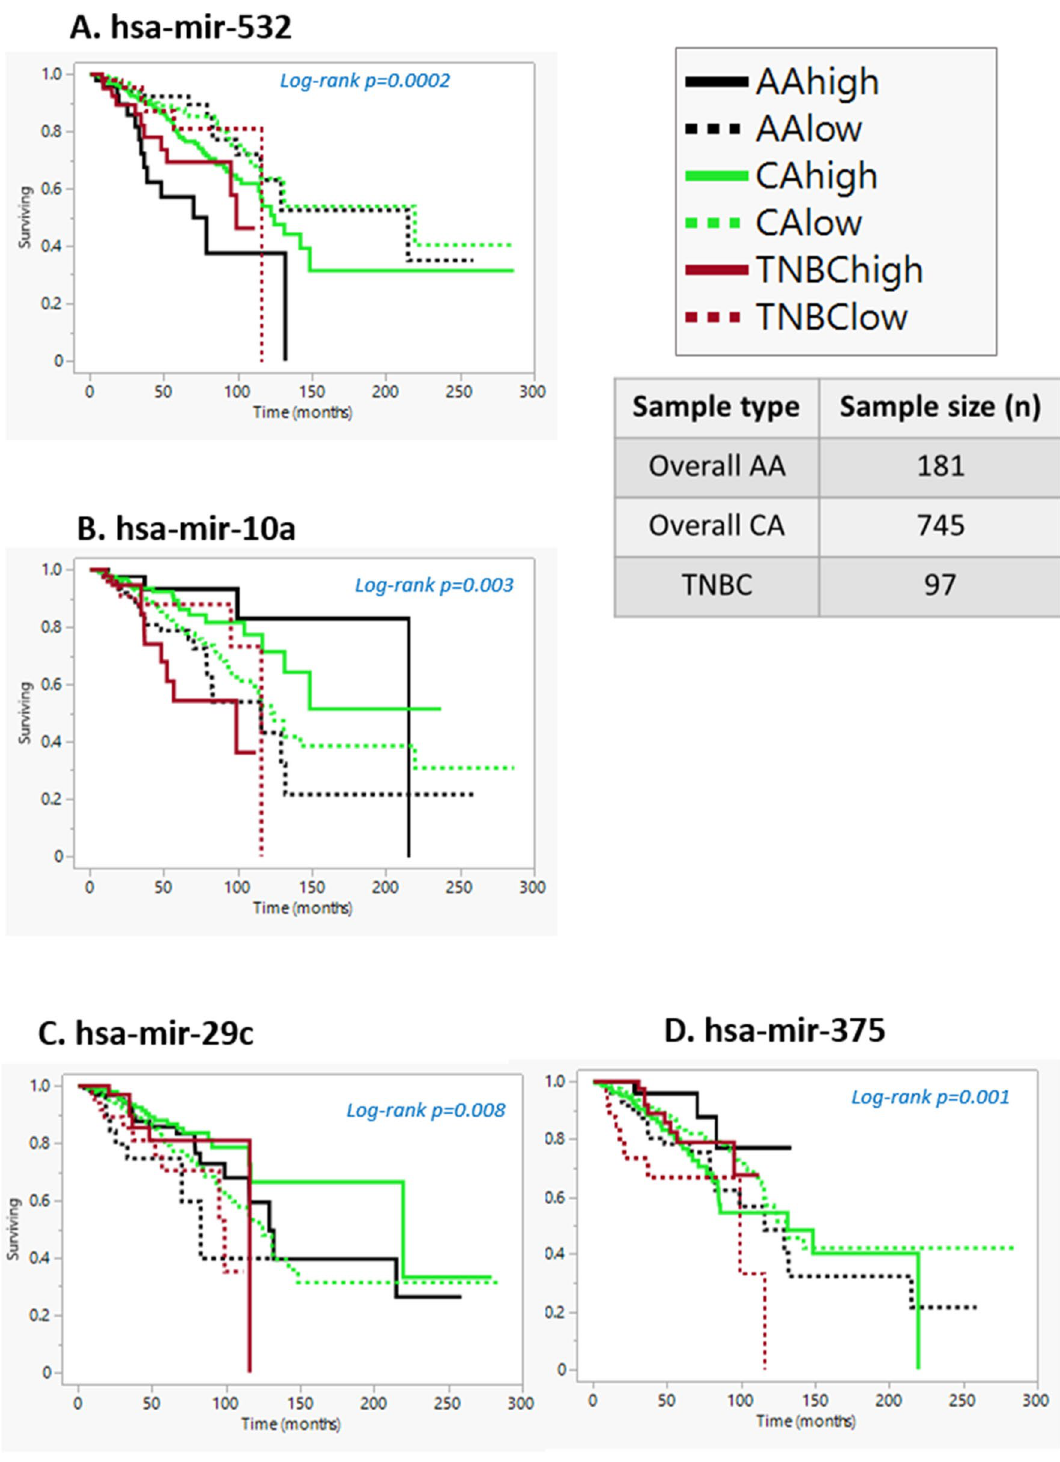
Figure 4. Survival analysis of mir-532, mir-10a, mir-29c, and mir-375 for overall AAs (n = 181), Overall CA (n = 745), and TNBCs (n = 97). Irrespective of race or subtype hsa-mir-532 high levels seem to have lower survival rates AA, CA and TNBC patients. AA and CA patients with low levels of hsa-mir-10lower survival, however there is a trend that TNBC patients with high levels of has-mir-10a seems to have lower survival rates. Irrespective of race or subtype hsa-mir-375 and hsa-mir-29c low levels seems to have lower survival rates AA, CA and TNBC